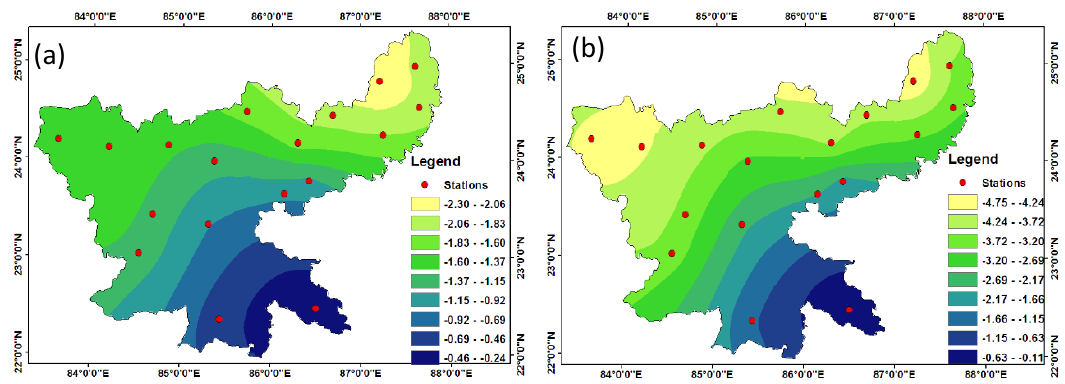
Figure 8. Spatial distribution of temporal change in Monsoon rainfall during 1901 to 2002 ( a ) and from 1952 to 2002 ( b ).